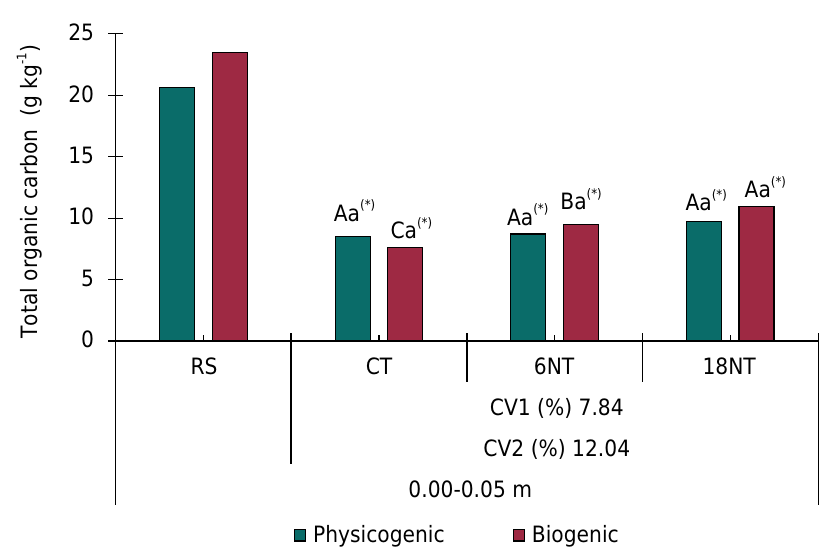
Figure 4. Total organic carbon content in physicogenic and biogenic aggregates in the 0.00-0.05 m soil layer under different management systems in the Cerrado region of Uberaba, Minas Gerais, Brazil. Different uppercase and lowercase letters indicate significant differences between sites and aggregate types, respectively, by Tukey’s test (p<0.05). An asterisk (*) indicates a significant difference from the reference site (Dunnett’s test, p<0.05). ns: not significant; RS: reference site, a well-preserved fragment of the Brazilian Cerrado; CT: 20-year conventional tillage; 6NT: 6-year no-till; 18NT: 18-year no-till; CV 1 : coefficient of variation between aggregate types; CV 2 : coefficient of variation between sites.